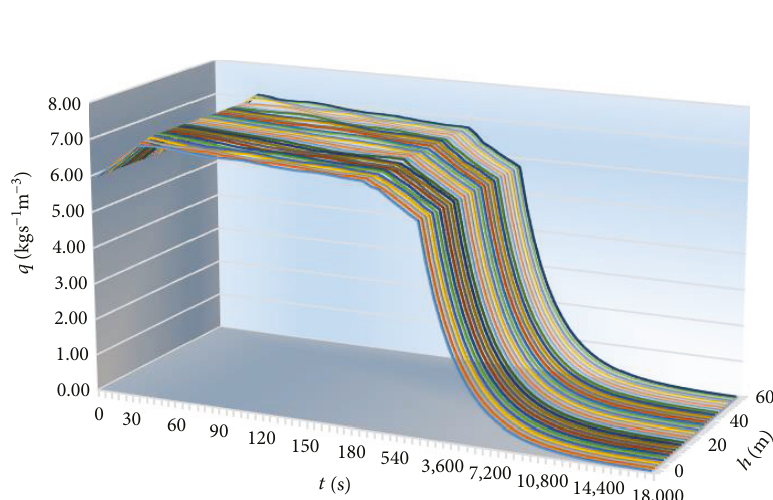
Figure 12: Spatiotemporal distribution of mass-loss rate of the actual